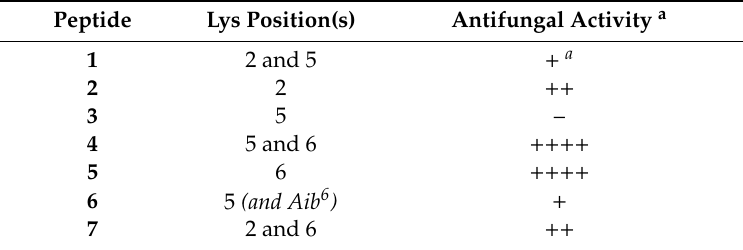
Table 4. Comparison of the performances of Lys-containing analogs against B. cinerea. Peptide Lys